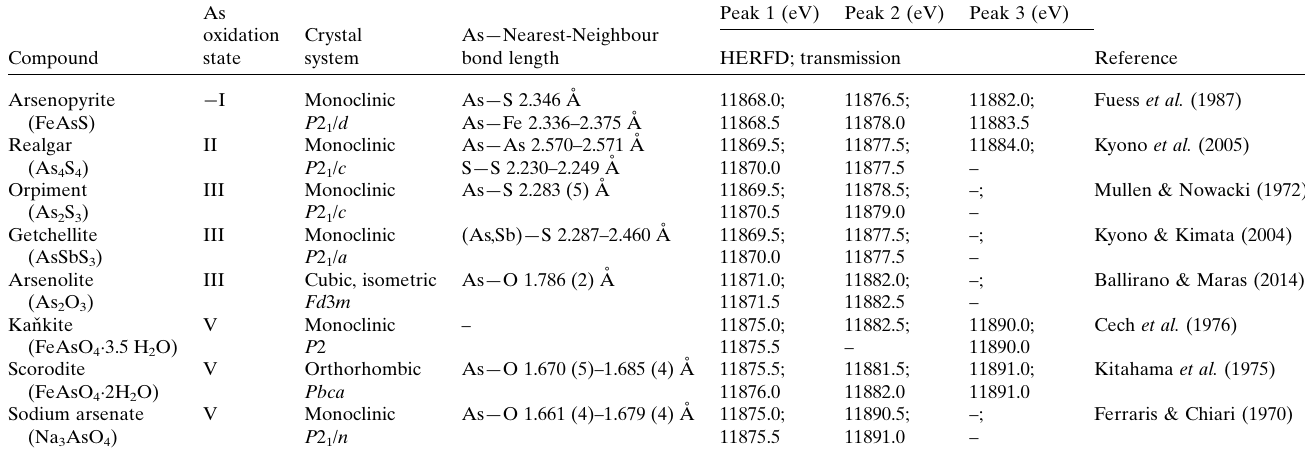
Table 1 Molecular and crystallographic information for the As reference compounds and locations of identified peaks in the HERFD-XANES and transmission- detected XANES